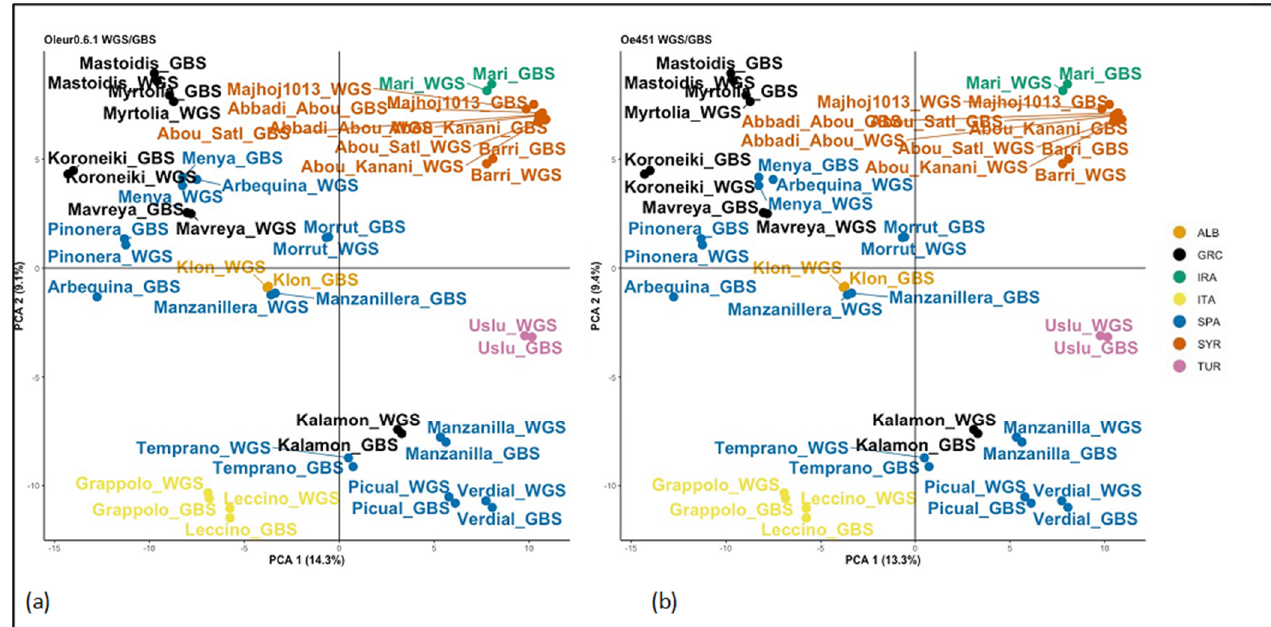
Figure 2. PCA clustering of WGS/GBS datasets. This shows the clustering of WGS and GBS merged samples. Principle components 1 and 2 are shown for each. ( a ) PCA of merged data with reference genome Oe451; ( b ) PCA of merged data with reference genome